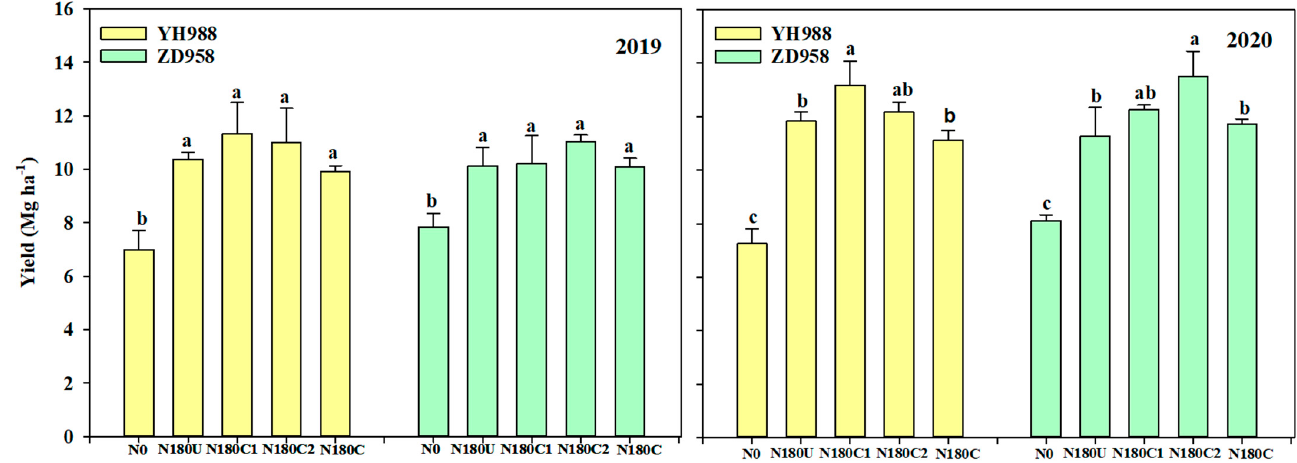
Table 2. Maize aboveground N uptake and N use efficiency (NUE) in 2019 and 2020.